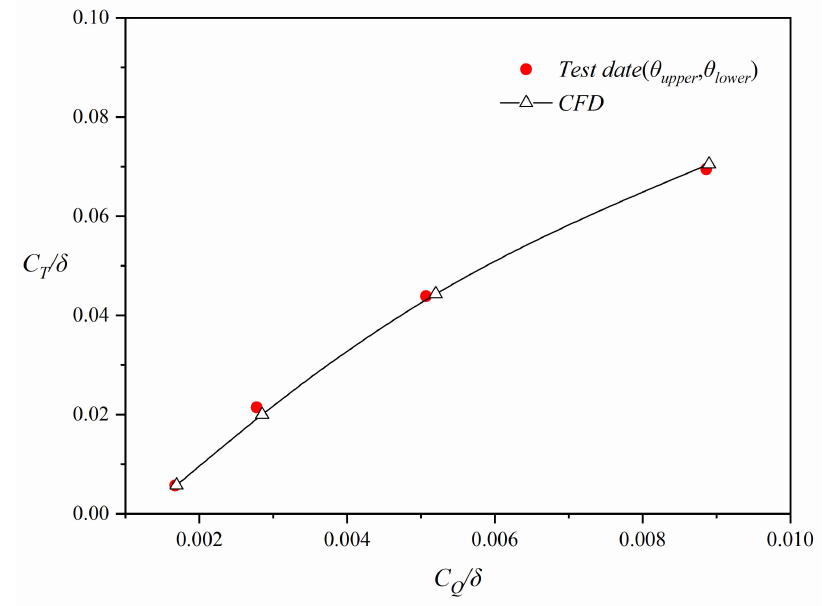
Figure 6. Coaxial rotor total C T and C Q in hover